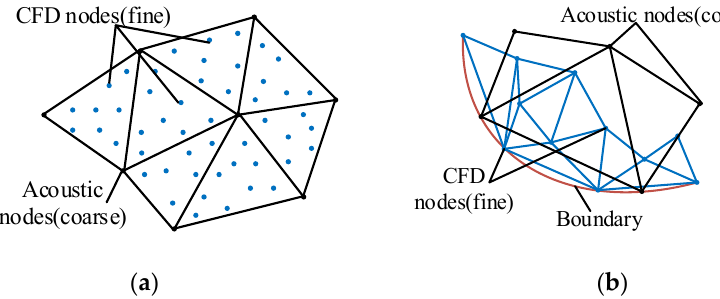
Figure 7. Grid interpolation method: ( a ) integration solution ; ( b ) solution at boundary.